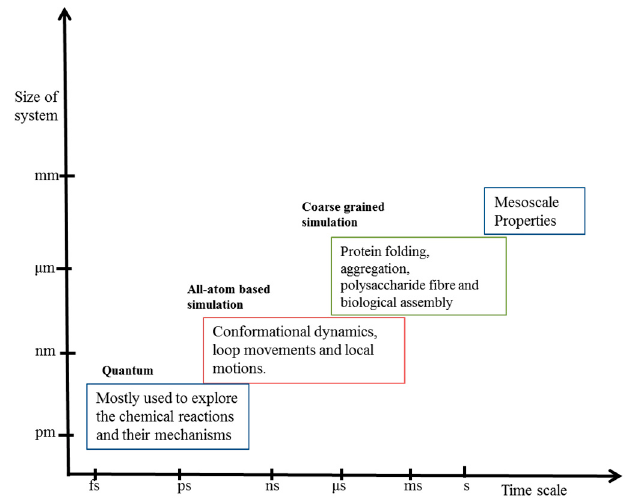
Figure 1. The Molecular Dynamics Simulations at different levels of resolutions (Quantum, all-atom and coarse grained) and their applicability to approximate size of biological systems and time